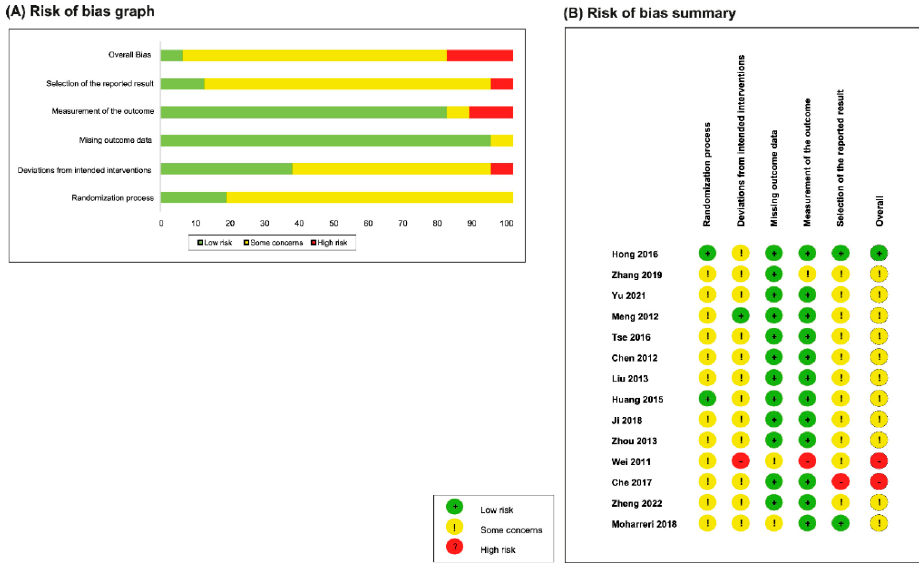
Figure 2. Risk of bias. ( A ) Risk ‐ of ‐ bias graph. ( B ) Risk ‐ of ‐ bias summary [14–27].